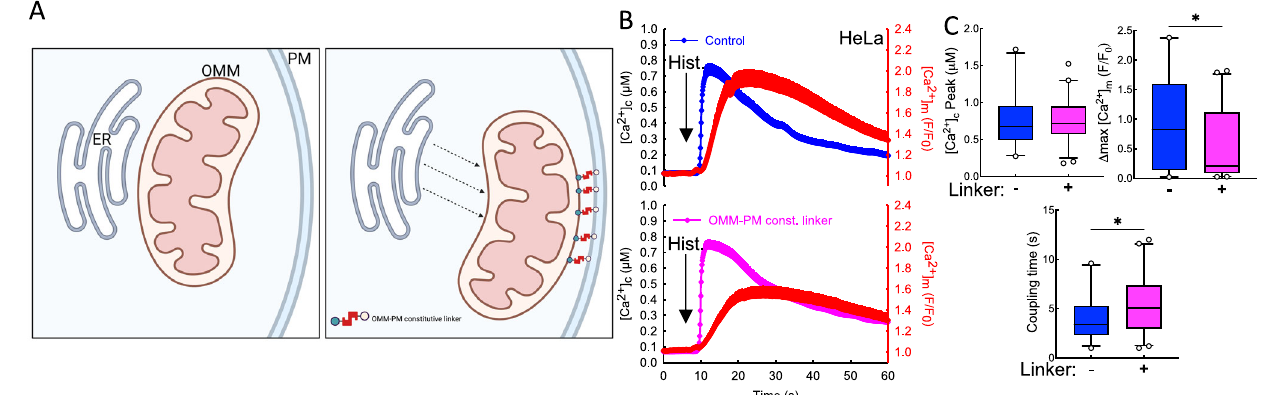
Fig. 5 | ER-mitochondrial Ca 2+ communication is disrupted by relocating mitochondria to the plasma membrane. A Scheme depicting the disruption of ERMCs by the expression of PM-OMM constitutive linkers in WT HeLa cells. (Cre- ated in BioRender) B Average traces showing the effect of PM-OMM constitutive linker expression on ER-mitochondrial Ca 2+ transfer after histamine stimulation compared to control cells expressing only OMM-mRFP (PM-OMM n =44, OMM